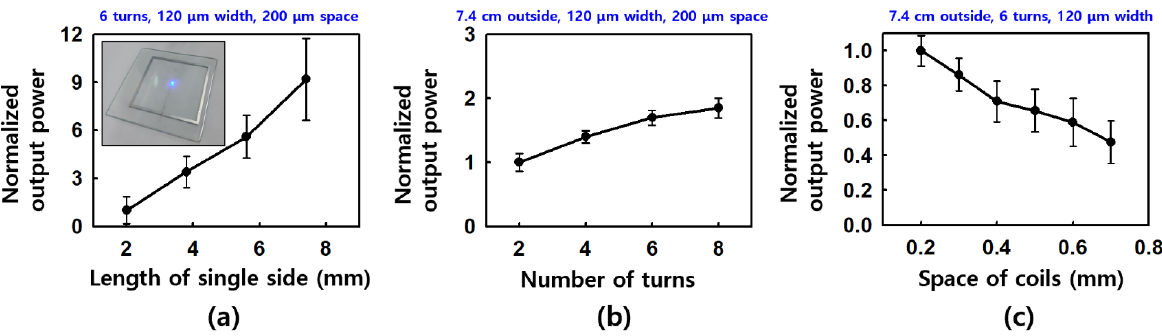
Figure 3. Antenna performance comparison of the receiving antennas according to the length of the outer side ( a ), the number of rotations ( b ), and the spacing of the coil ( c ), respectively. The inset image of ( a ) shows the wirelessly operated LED device with a connected antenna.